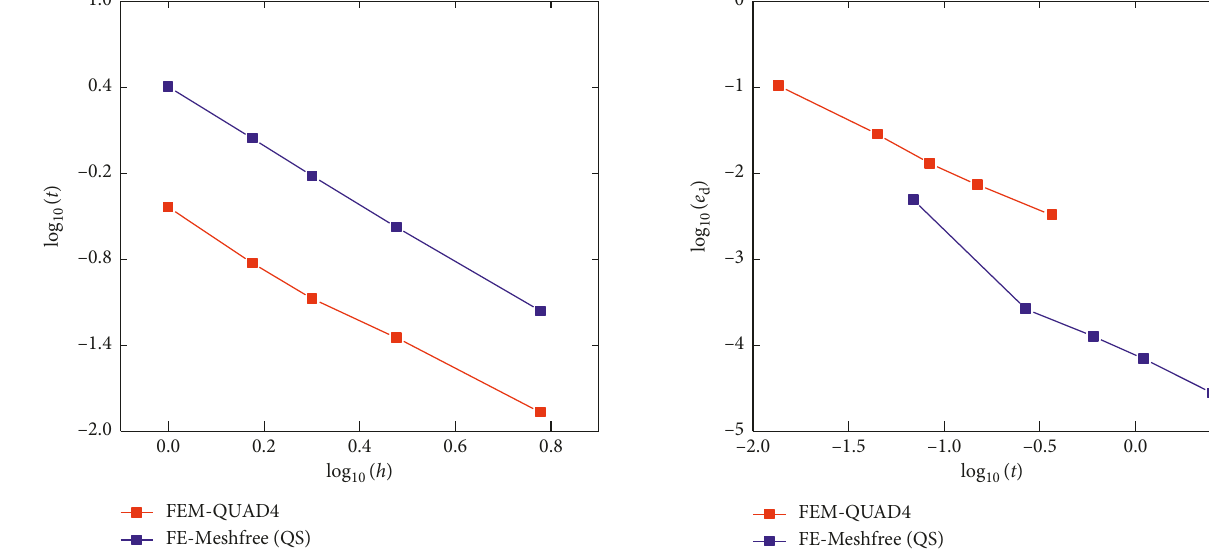
Figure 10: Computation time.